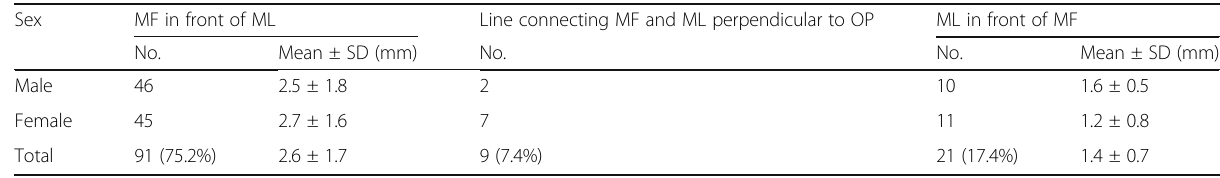
Table 5 Anteroposterior relationship of ML and MF on occlusal plane Sex MF in front of ML Line connecting MF and ML perpendicular to